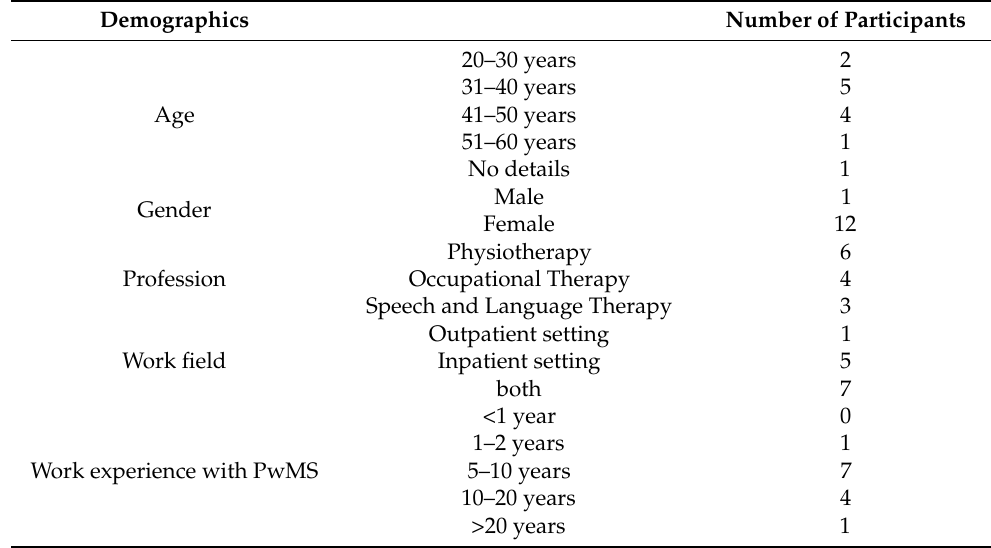
Table 3. Sociodemographic data of participants from the focus groups.